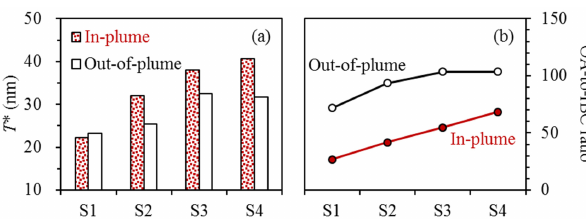
Figure 12. Evolutions of (a) coating thickness for rBC cores in the D MEV range of 130–160nm ( T ∗ ) and (b) OA-to-rBC mass ratio (OA / rBC) during the transformation flight F_9/4. Only median values are shown for T ∗ and OA / rBC. Quantitative discussions on OA / rBC have been presented elsewhere (Liggio et al., 2016), whereas statistical results are shown in Fig. S5 for T ∗ measured dur- ing F_9/4 (together with T ∗ measured during the other two trans- formation flights). Evolution of coating thickness for rBC cores in the D MEV range of 160–190nm (Fig. S6) exhibits the same pat- tern as that shown in (a) . It should also be noted that the out-of- plume OA are dominated by preexisting secondary organic aerosols formed from biogenic precursors (Liggio et al., 2016), which do not contribute to the formation of coating materials on rBC cores. This explains why the out-of-plume conditions have higher OA / rBC ra- tios but in general lower T ∗ compared to in